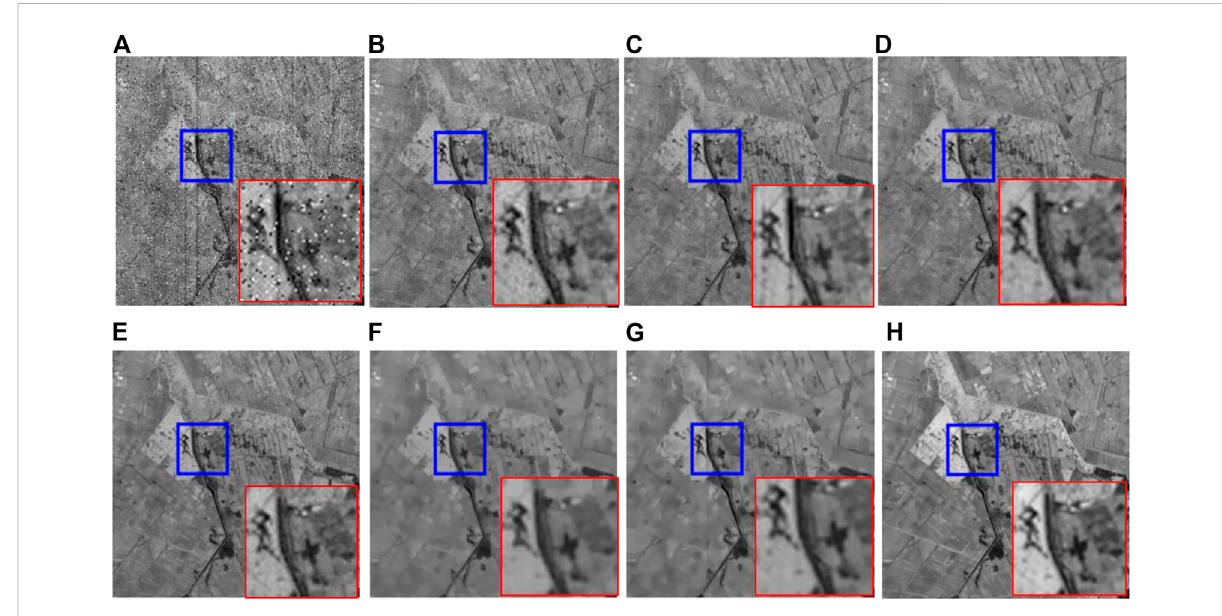
FIGURE 11 Restored results of GF-5 HSI data of Baoqing: (A) Noisy, (B) L 1-2 SSTV, (C) QRNN3D, (D) LRTDGS, (E) SBNTRD, (F) LRTF- L 0 , (G) ANTRRM, (H) OURS. Please zoom in for better viewing.